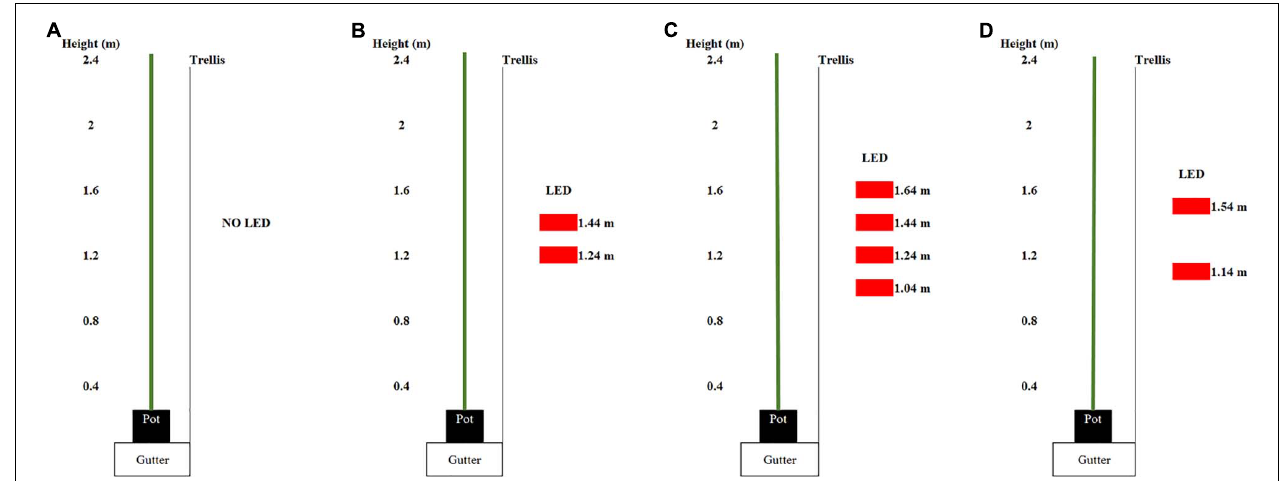
FIGURE 1 | Arrangement of the light emitting diode (LED) modules (displayed as red rectangles) in the spring crop cycle for (A) 0, (B) 93, and (C) 185 intercanopy lighting (ICL) and in the autum crop cycle (D) . The numbers beside the LED modules show the distance from the LED module to the